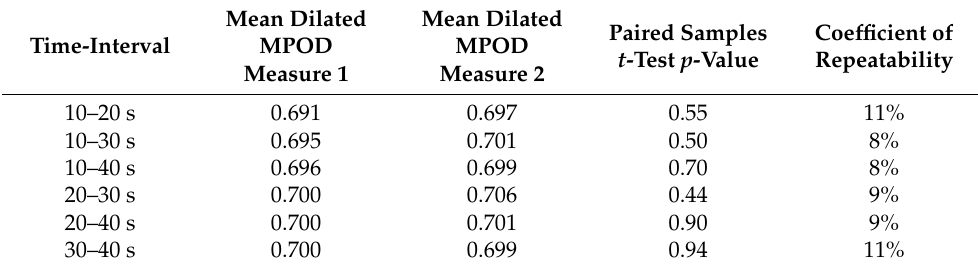
Table 2. Mean MPOD obtained using the Macular Pigment Reflectometry with pupillary